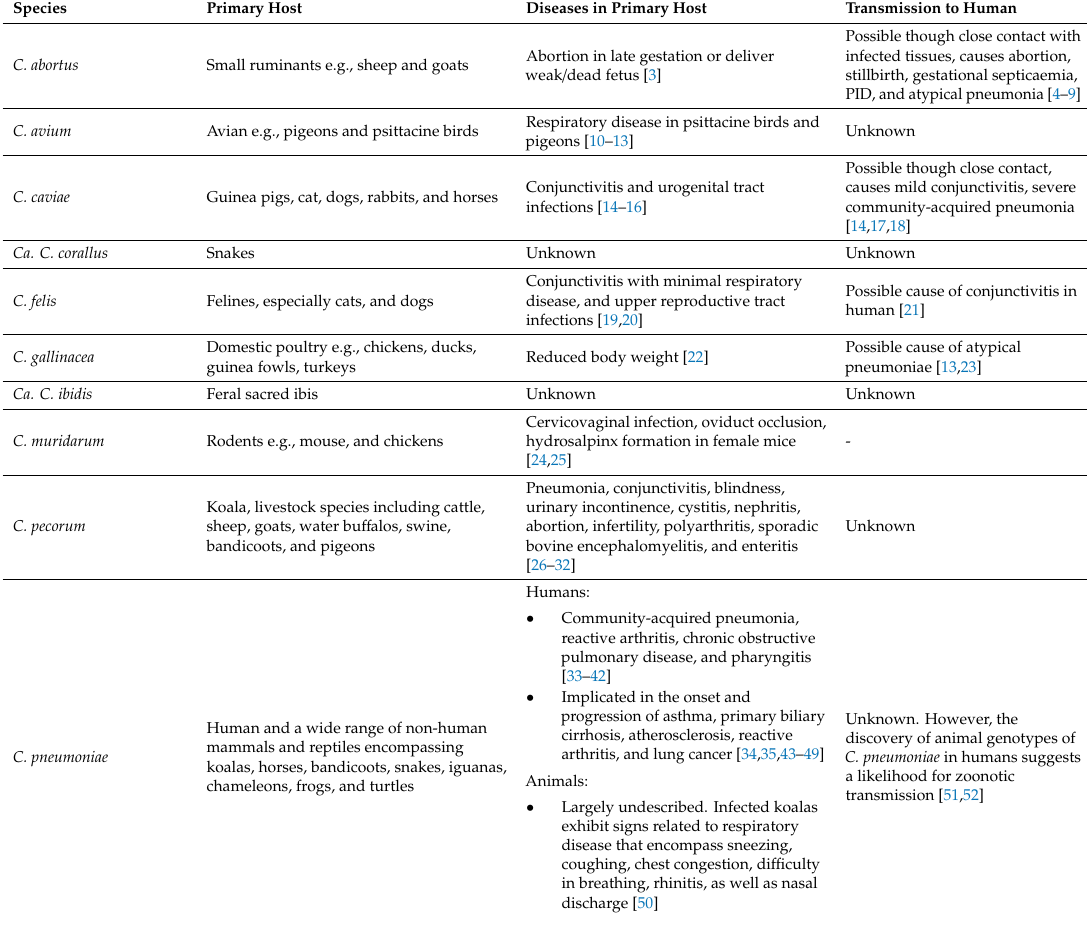
Table 1. The list of members in the Chlamydiaceae family, and the diseases caused by each species in their primary host and human. PID: pelvic inflammatory